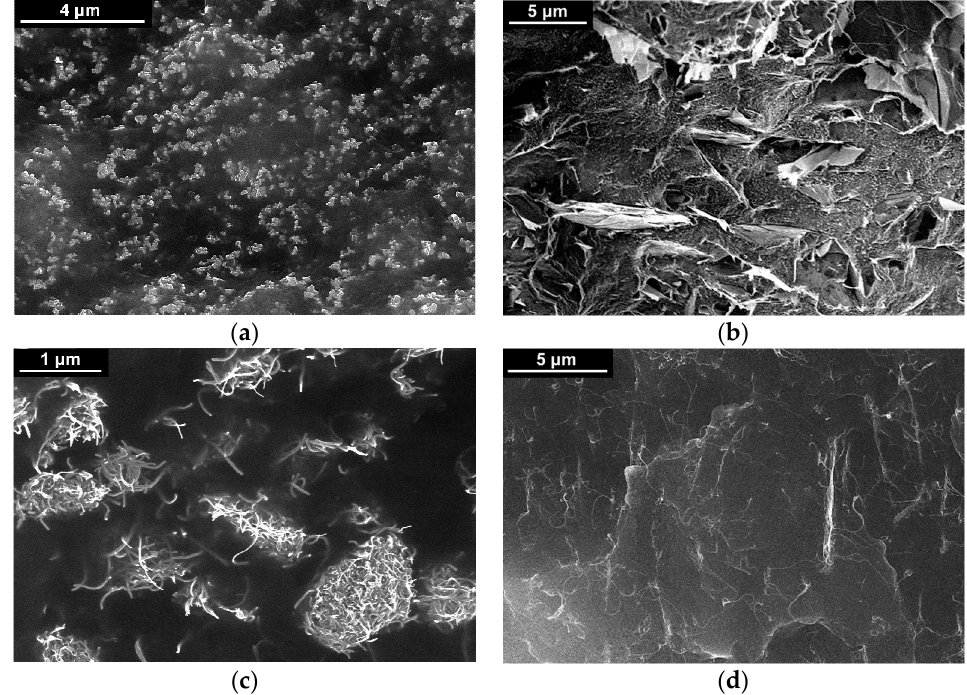
Figure 3. Results of scanning electron microscopy of low-temperature cleavages of composites based on PP filled with carbon nanoparticles with certain weight content: ( a )—15 wt.% CB; ( b )—10 wt.% GnPs; ( c )—7.5 wt.% MWCNTs; ( d )—0.5 wt.% SWCNTs.